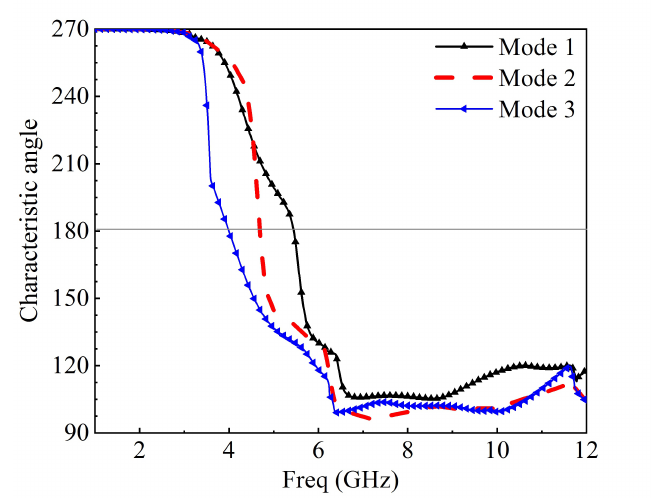
Figure 8. Characteristic angle curve of three modes at 5.2 GHz.